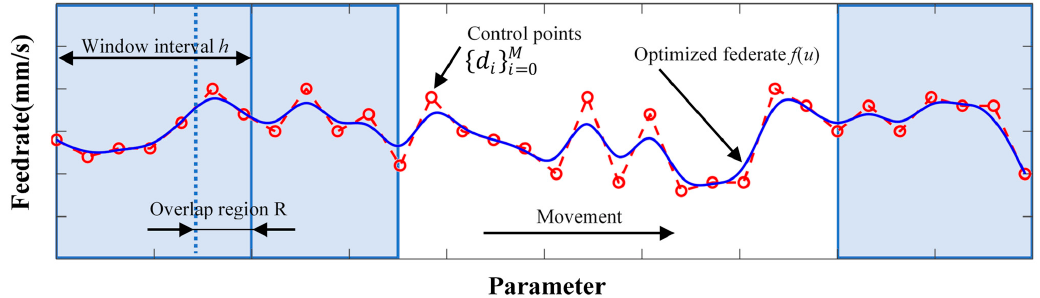
Figure 5. Diagram of the window moving method.